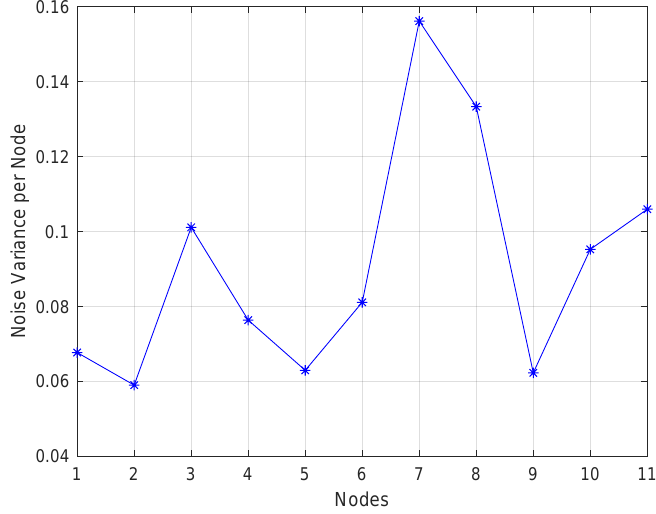
Figure 5. Noise variance per